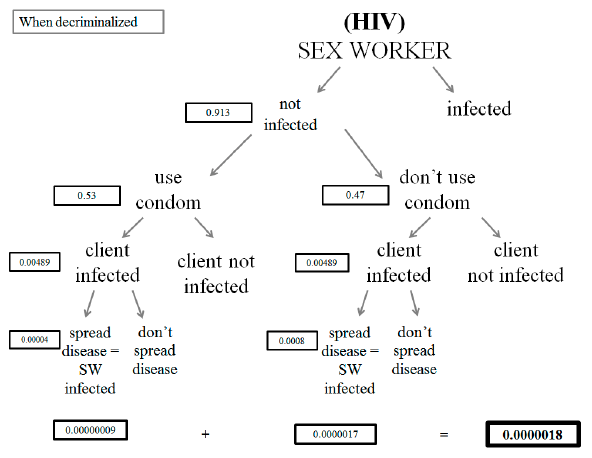
Figure A6. Risk of HIV transmission to a sex worker under criminalization.